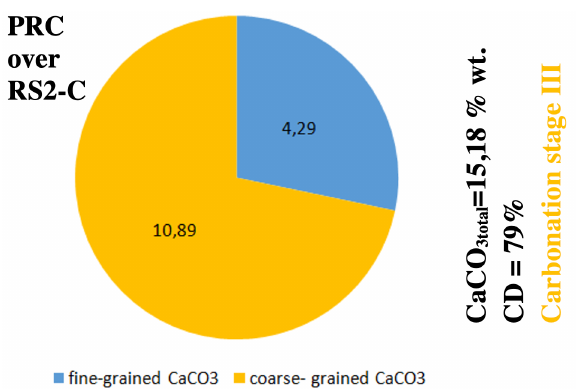
Figure 14. The amount of CaCO 3 (% wt.) in the PRC sample over RS2-C.